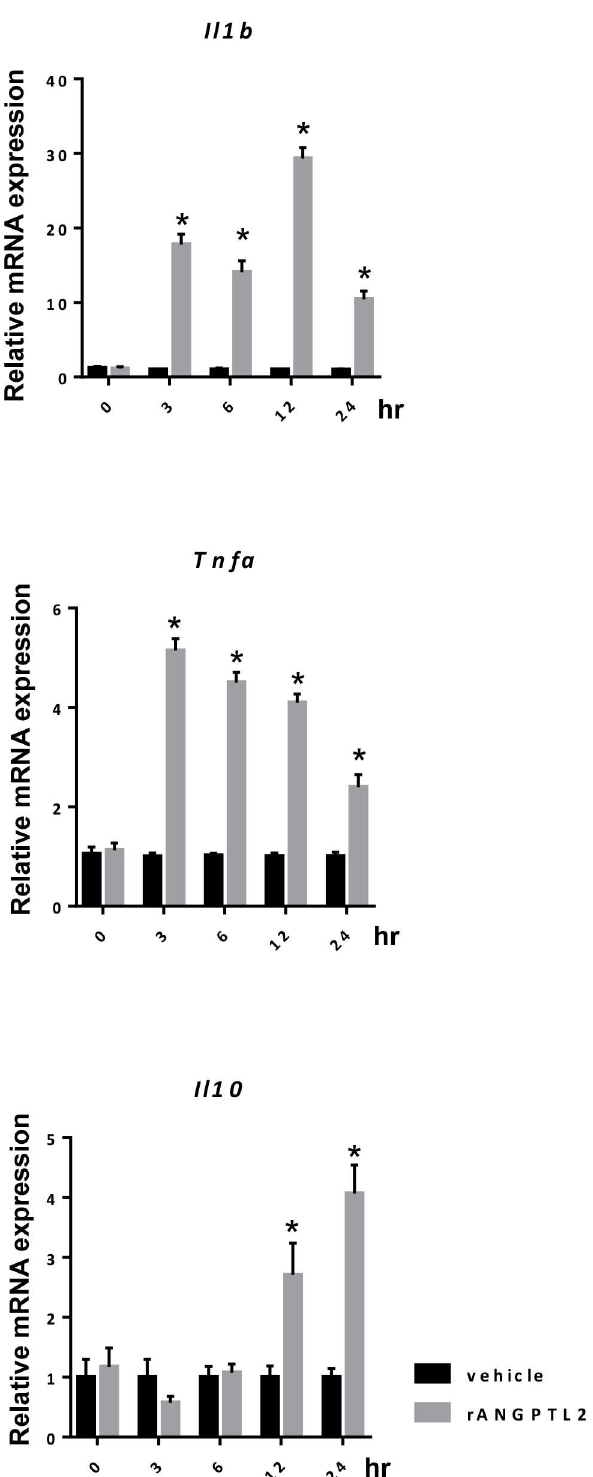
Fig 5. ANGPTL2 increasestranscription of genes encoding pro-inflammatory cytokines in macrophages. mRNA expressionlevels of (left) Il1b , (middle) Tnfa , and (right) Il10 followingeither vehicleor recombinant ANGPTL2 (rANGPTL2) treatment of RAW 264.7 cells (n = 5). mRNAs were harvestedat 0, 3, 6, 12, 24 hours after cells were treated with 5 μ g/mL rANGPTL2. Data are normalized to Actb levels. mRNA expressionin vehicle-treated cells was set to 1 for each transcript assessed. Results are expressed as means ± s.e.m. * P <